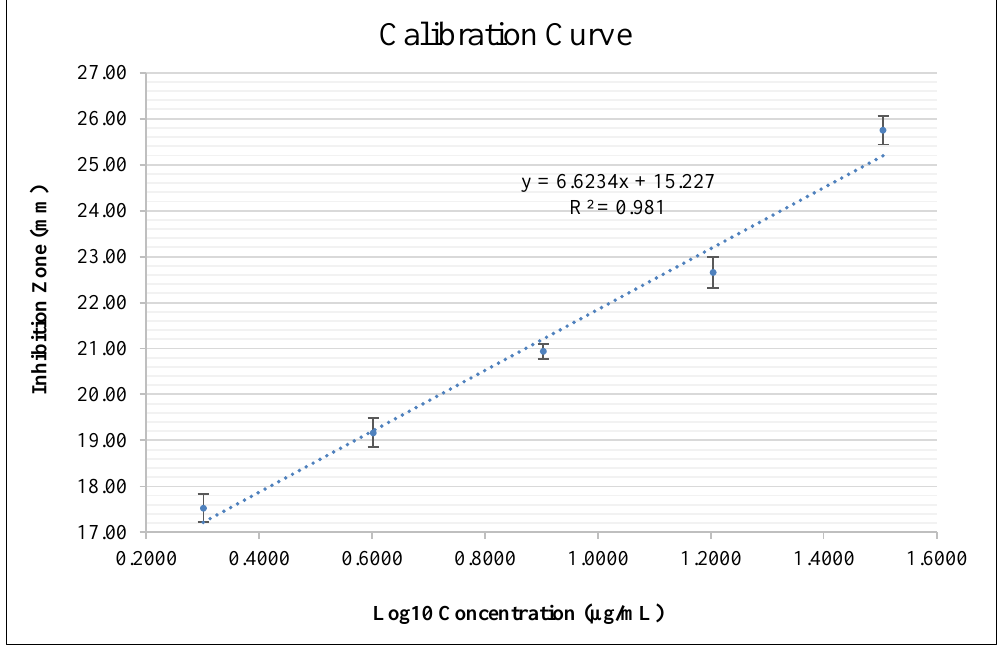
Figure 1. Calibration curve for Gentamicin linearity assessment covering the range between 0.0002 and 0.0032 g/100 mL w/v (%) showing mean ±